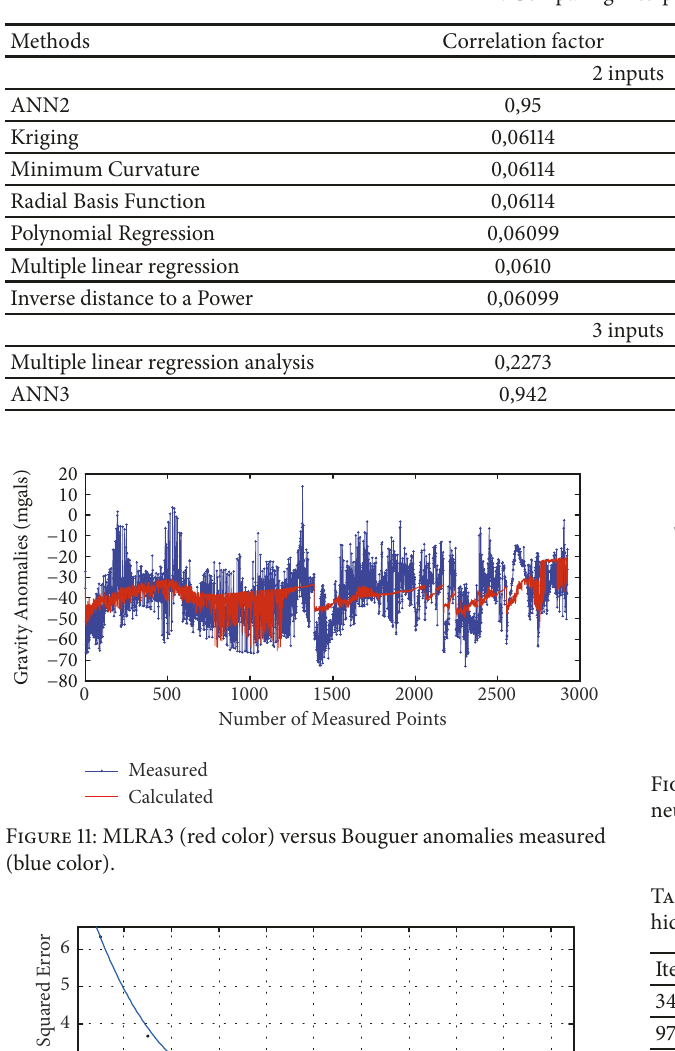
Table 1: Comparing interpolation methods.